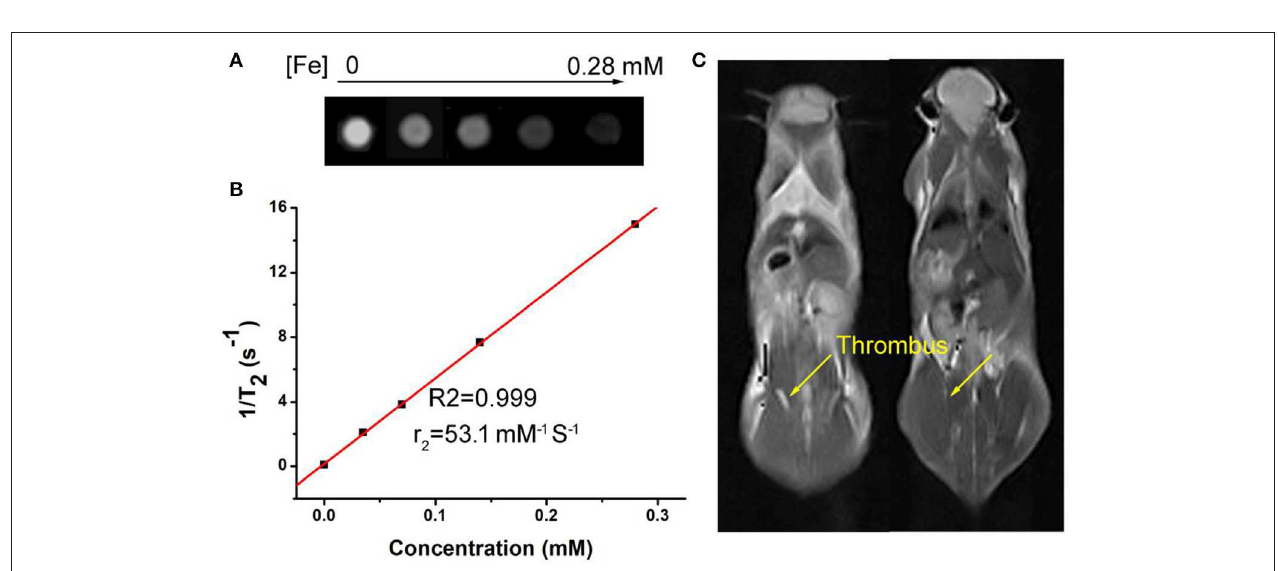
FIGURE 5 | (A) Phantom images of the Fe 3 S 4 nanoparticles. (B) Proton T 2 relaxation measurements at varied Fe concentrations (C) T 2 -weighted MR imaging in vivo of a mouse with celiac vein thrombosis before (left) and after (right) an intravenous injection of a solution of the Fe 3 S 4 nanoparticles followed by the simulation of